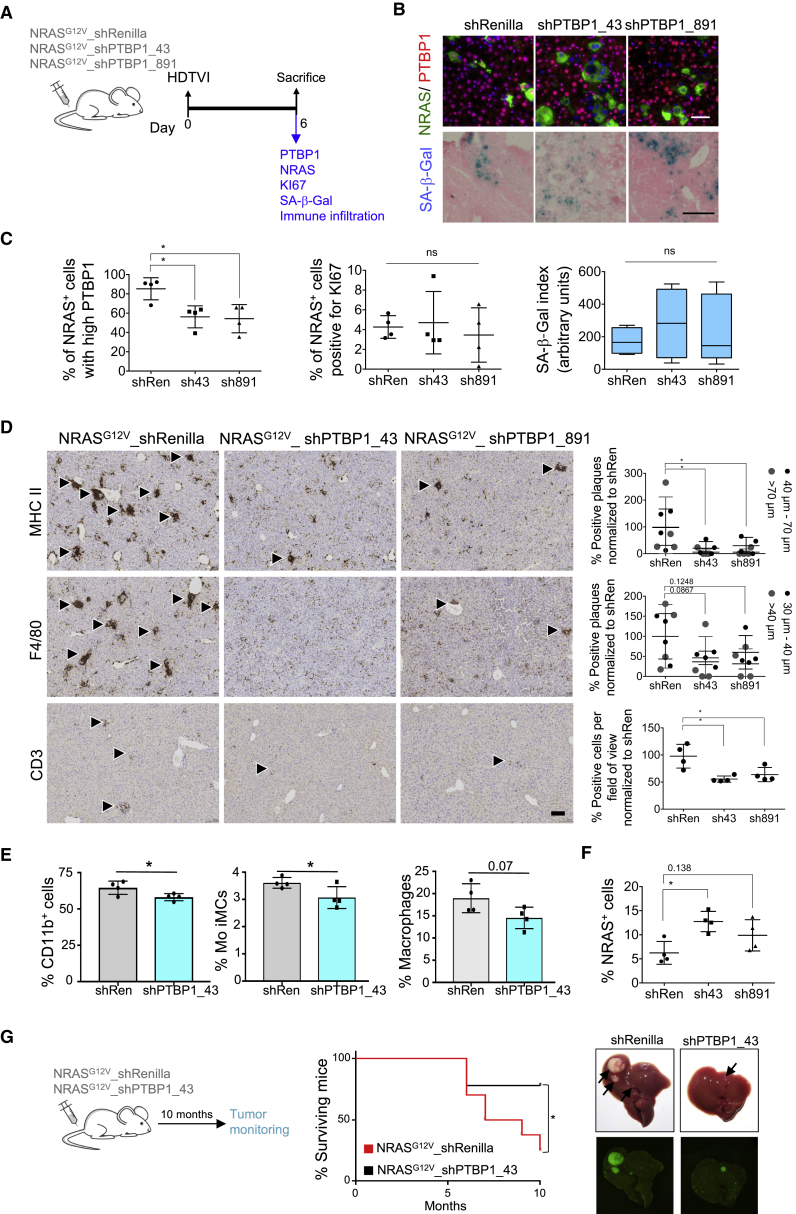
PTBP1 Knockdown Impairs Senescence Surveillance without Increasing Tumorigenesis(A–F) Senescence surveillance following PTBP1 knockdown. (A) Experimental design. (B) Representative IF images of NRAS, PTBP1 and SA-β-galactosidase expression in livers. Scale bars, 50 μm. (C) Quantification of high PTBP1-expressing or Ki67+ among NRAS+ cells by IF. Quantification of SA-β-gal expression is also shown (right). Plots show median (line), upper and lower quartiles (boxes), and lines extending to highest and lowest observation (whiskers). Data represent mean ± SD (n = 4). ∗p < 0.05; ns, not significant. Comparisons with NRASG12V-shRenilla, one-way ANOVA (Dunnett's test). (D) Representative IHC images (left) and densitometric quantification (right) of indicated immune cell markers. For MHCII+ and F4/80+ areas, arrowheads indicate characteristic myeloid aggregate formation that develops as a consequence of NRASG12V-driven senescence in the liver. Smaller aggregates are separated from larger aggregates based on diameter (comparison shown in Figures S6A and S6B) and are depicted as black and gray symbols, respectively. For CD3+ staining, arrowheads indicate positive cells and are quantified as number of positive cells per counting area (10 mm2). Scale bar, 100 μm. Data represent mean ± SD (n = 4). ∗p < 0.05. Comparisons with NRASG12V-shRenilla, one-way ANOVA (Bonferroni’s test). (E) Quantification of indicated infiltrating immune cells by flow cytometry. Gating strategy shown in Figures S6C and S6D. Data represent mean ± SD (n = 4); ∗p < 0.05. Comparisons with NRASG12V-shRenilla, one-way ANOVA (Bonferroni’s test). (F) Quantification of NRAS+ cells. Data represent mean ± SD (n = 4); ∗p < 0.05. Comparisons with NRASG12V-shRenilla, one-way ANOVA (Bonferroni’s test).(G) Long-term tumorigenesis in WT mice upon injection with indicated transposon-based plasmids. Left: experimental design. Middle: Kaplan-Meier survival curves. Right: NRASG12V_shRen (n = 10) and NRASG12V_shPTBP1 (n = 9). ∗p < 0.05 by log-rank (Mantel-Cox) test. Representative images of macroscopically visible GFP+ tumor nodules (>1 mm, black arrows) at endpoint.See also Figure S6.